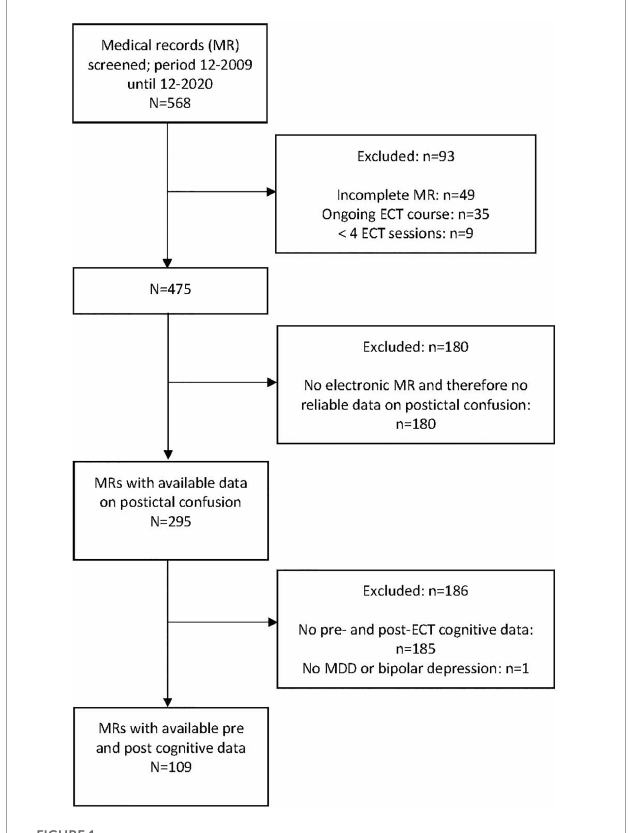
FIGURE1 Flowchart of patient